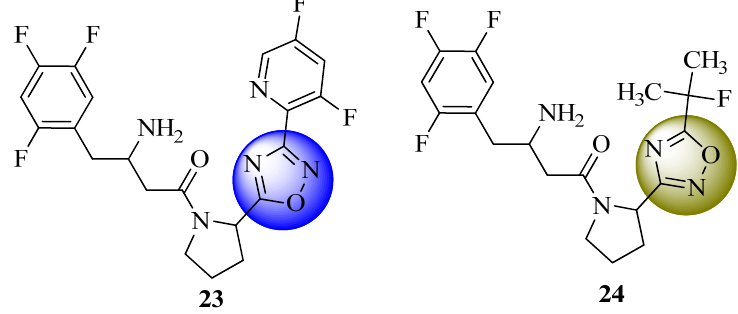
Figure 15. β -homophenylalanine-based inhibitors of DPP-IV.